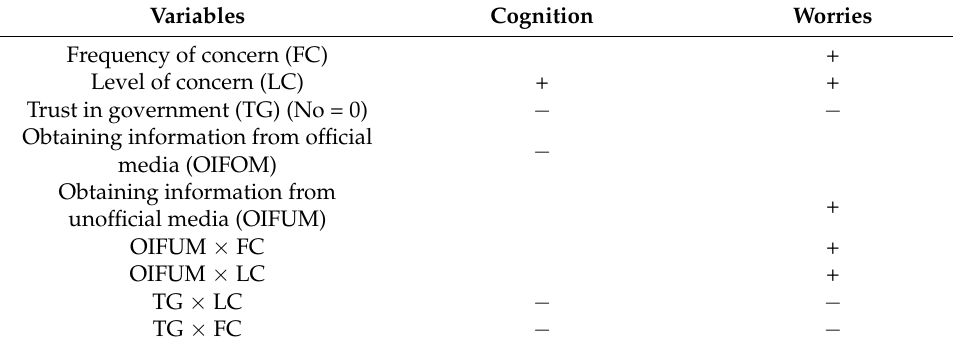
Table 6. Main results of